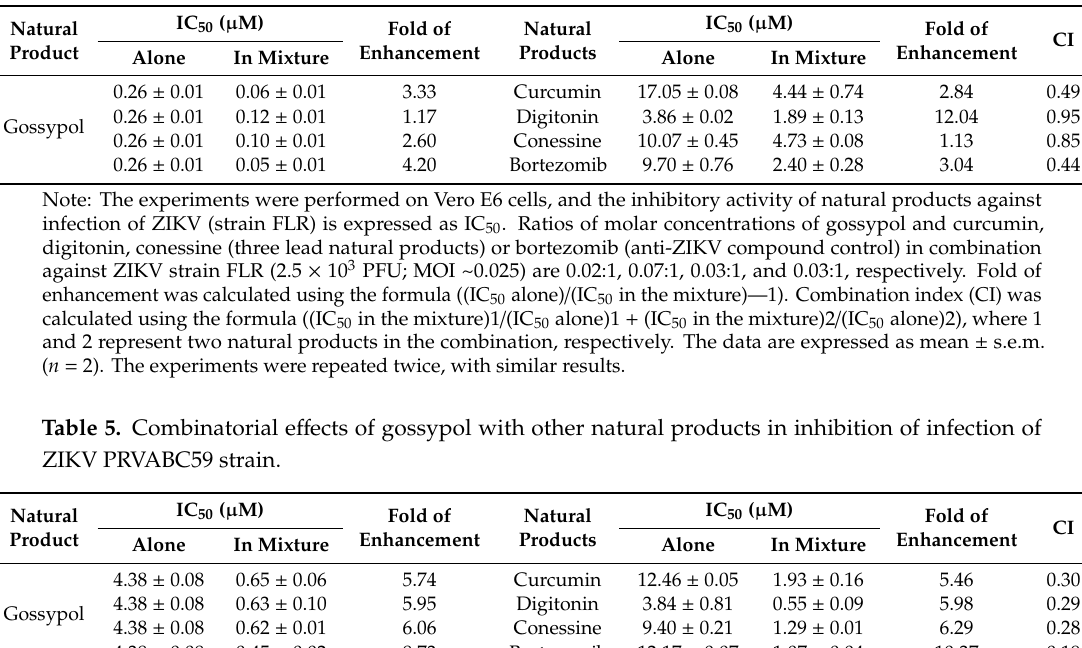
Table 4. Combinatorial e ff ects of gossypol with other natural products in inhibition of infection of ZIKV FLR strain.